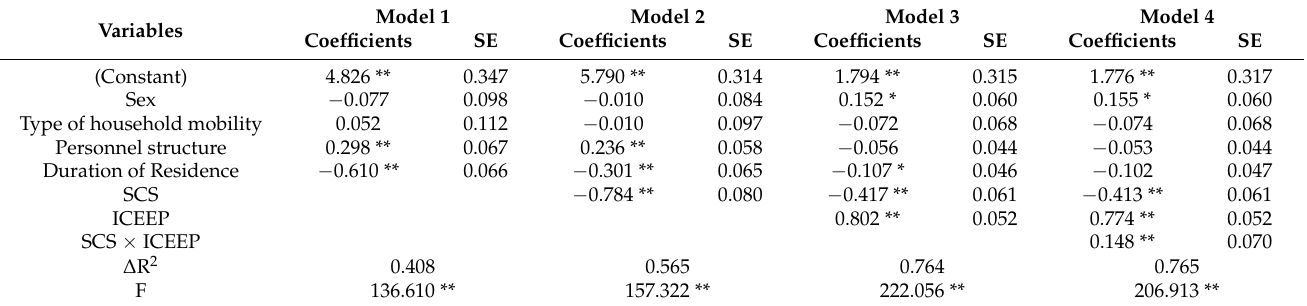
Table 4. Moderating effect of ICEEP on the relationship between SCS and